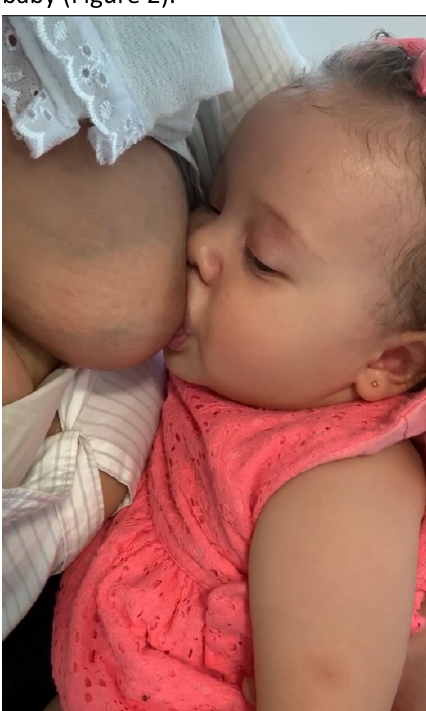
Figure 2. Mother was instructed to allow for a greater mouth opening and catch on of the